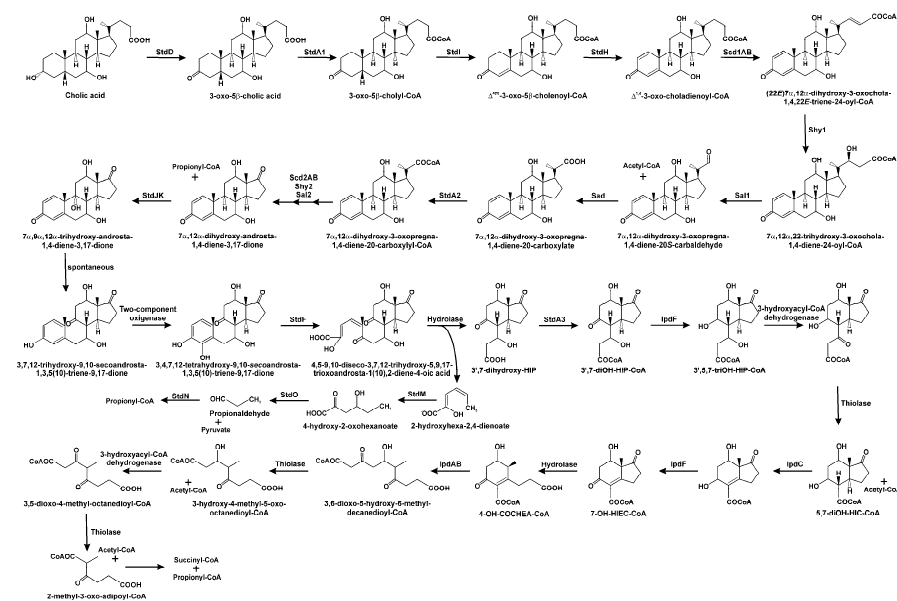
Figure 6. Cholic acid metabolism in Pseudomonas putida DOC21 and P. stutzeri Chol1 through the 9,10- seco pathway. Preliminary evidence suggests that oxidation of the A-ring occurs simultaneously with C 17 side chain degradation. Hydroxyl groups at C 7 and C 12 are maintained during degradation of the molecule, the affecting 3a α -H-4 α (3’-propanoate)7a- β -methylhexahydro-1,5- indanedione- hydroxylated derivatives metabolism. 3’,7-diOH-HIP, 3a α - H- 4 α (3’( R )-hydroxy-3’propanoate)-7- hydroxy-7a β -methylhexahydro-1,5-indanedione; 3’,7-diOH-HIP-CoA, 3a α - H- 4 α (3’( R )-hydroxy- 3’propanoyl-CoA)-7-hydroxy-7a β -methylhexahydro- 1,5-indanedione; 3’,5,7-triOH-HIP-CoA, 3a α - H -(3 (cid:48) ( R )-hydroxy-3 (cid:48) pr opanoyl-CoA)-5,7-dihydroxy-7a β -methylhexahydro-1-indanone; 4OH-COCHEA-CoA, 2-(2-carboxye thyl)-4-hydroxy-3-methyl-6-oxocyclohex-1-ene-1-carboxyl-CoA; 7-OH-HIEC-CoA, (7a S )-7a-methyl-7- hydroxy-1,5-dioxo-2,3,5,6,7,7a-hexahydro-1 H -indene-4-carboxyl-CoA; 5,7-diOH-HIC-CoA, 3a α - H -4 α (3 (cid:48) -carboxyl-CoA)-5,7-dihydroxy-7a β